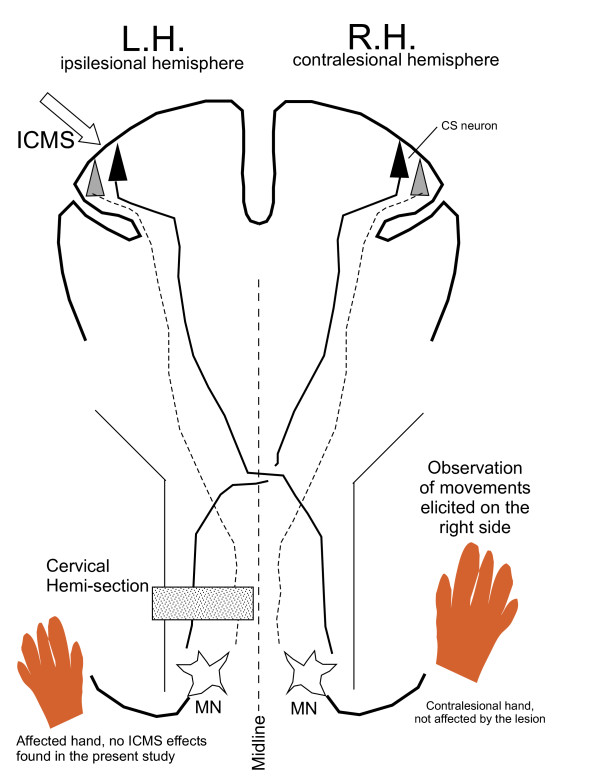
Experimental paradigm in Mks1-3. A cervical (left) sub-hemi-section at C7/C8 interrupted the main crossed corticospinal tract originating from the contralesional (right) hemisphere (RH) and the small, uncrossed, corticospinal tract, originating from the ipsilesional (left) hemisphere (LH). In order to assess the functional changes induced by the lesion in the ipsilesional hemisphere, electrode penetrations were performed in order to deliver intracortical microstimulations (ICMS) in the ipsilesional hemisphere. The effects of the ICMS were observed on the contralesional (right) side of the body, with emphasis on the contralesional hand, not affected by the lesion. In the present study, no effects were observed in the ipsilesional hand, affected by the lesion, for ICMS applied to the ipsilesional hemisphere. In other words, all ICMS effects reported in the present study are for the contralesional hand. MN = motoneuron